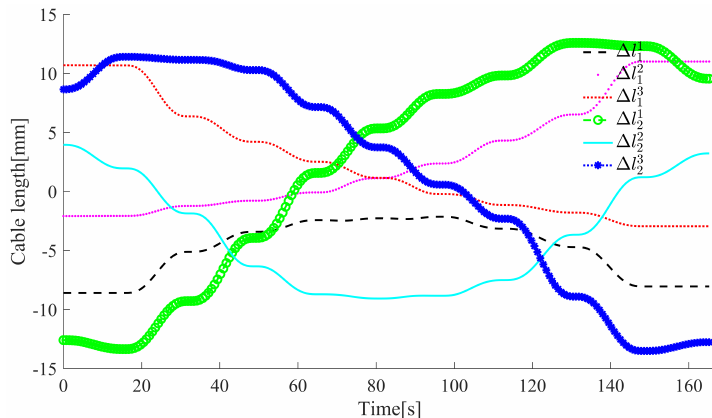
Figure 7. The trajectory planning results of the drive cable.